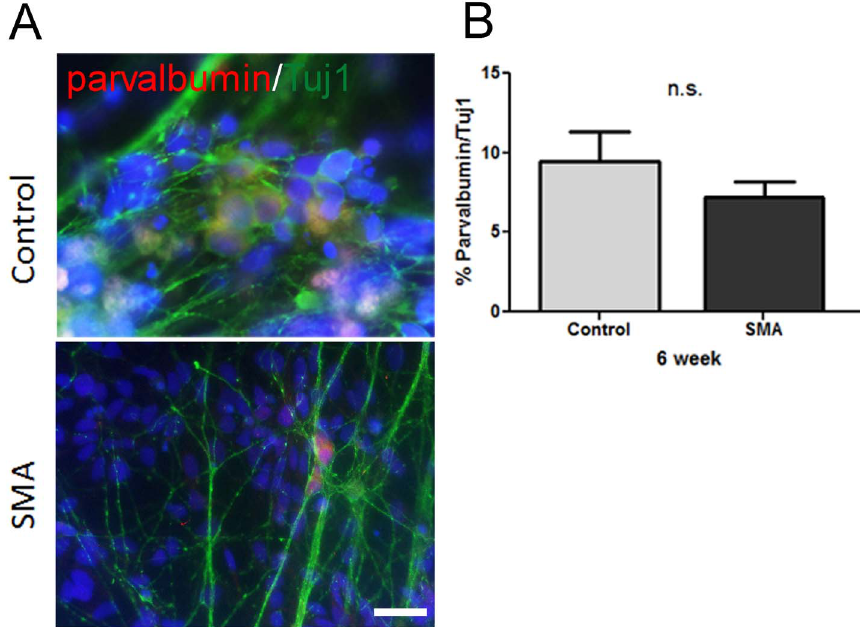
Figure 3. Generation of proprioceptive neurons from control and SMA iPSCs at 6 weeks of differentiation. (A) Both control and SMA iPSCs generate proprioceptive neurons as indicated by parvalbumin (red) and Tuj1 (green). Nuclei are labeled with Hoechst nuclear dye (blue). (B) There was no difference in parvalbumin + neuron number between control and SMA iPSC cultures. n.s.=not significant by t-test. Scale bar=20 m m.